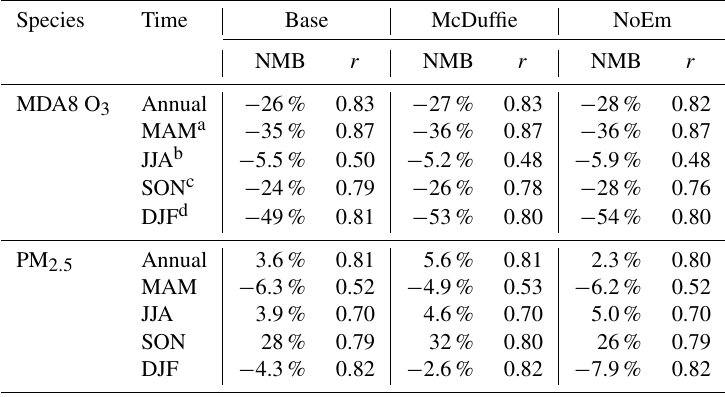
Table 3. Normalized mean bias (NMB) and correlation coefficients ( r ) between observed and simulated MDA8 O 3 and PM 2 . 5 concentrations during 2018 in